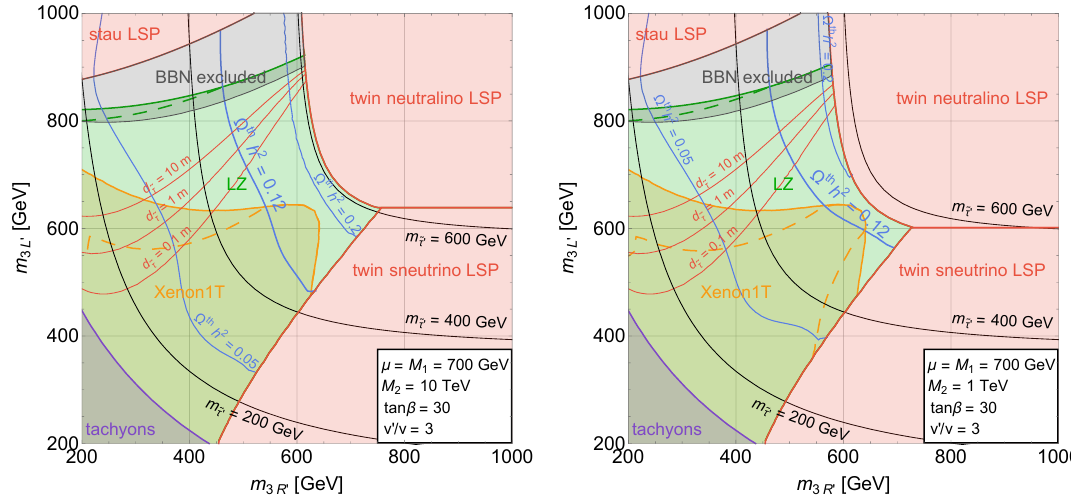
Figure 5. The same as in figure 3 but for µ = M 1 = 700 GeV and tan β = 30 . The left (right) panel has M = 10 (1) TeV. The contours of the stau decay length assuming the Higgsino mass 2 mixing are also